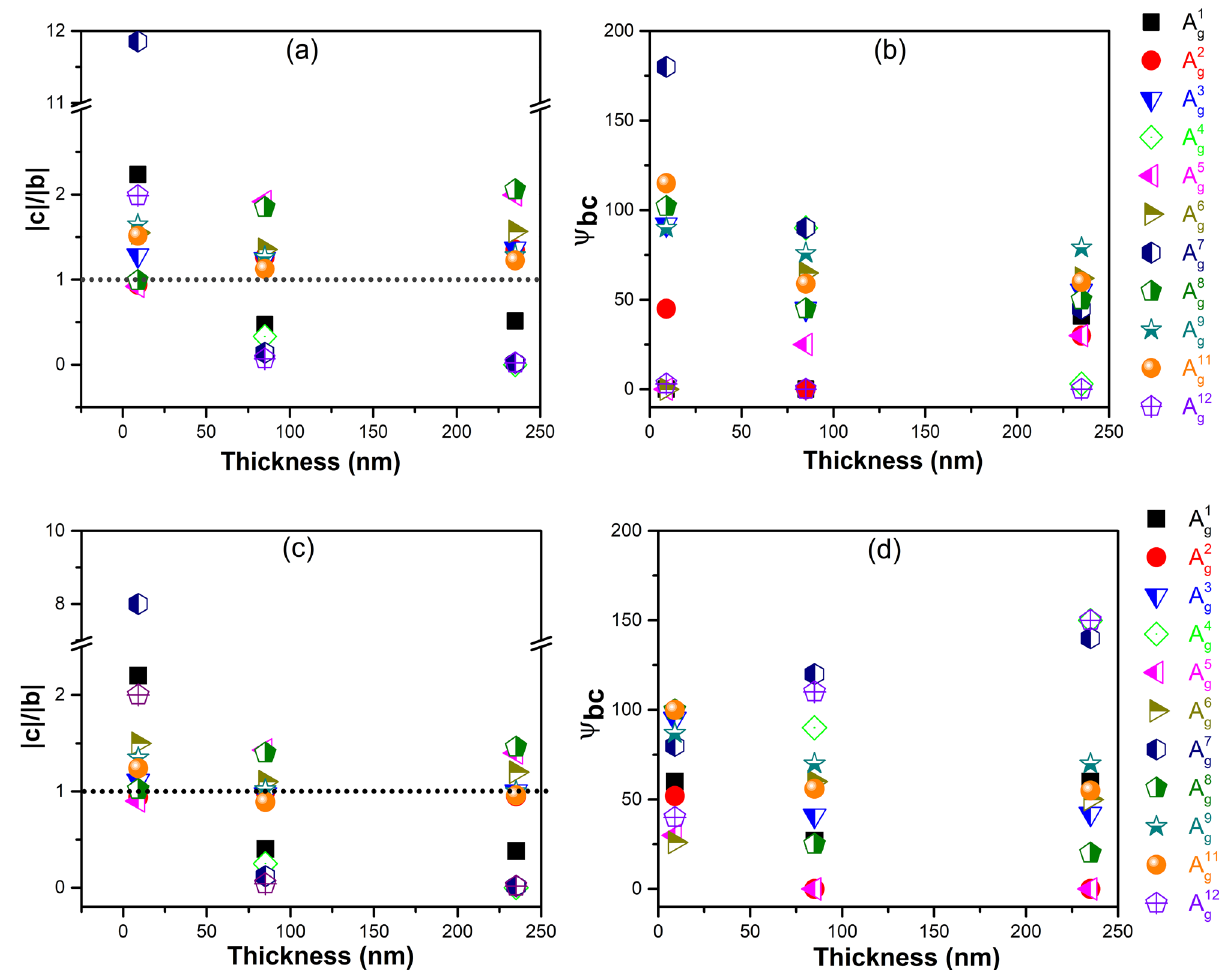
Figure 4. Thickness dependence of the amplitude ratio of Raman tensor elements | c | | b | , ( a,c ), and phase difference ψ bc =|ψ b − ψ c | ( b,d ), for all A g modes measured in parallel polarization configuration. The horizontal dotted lines in ( a,c ) indicates | c | | b | = 1. ( a,b ) Are the results before the elimination of the enhancement factor, and ( c,d ) are the results after the elimination of the enhancement